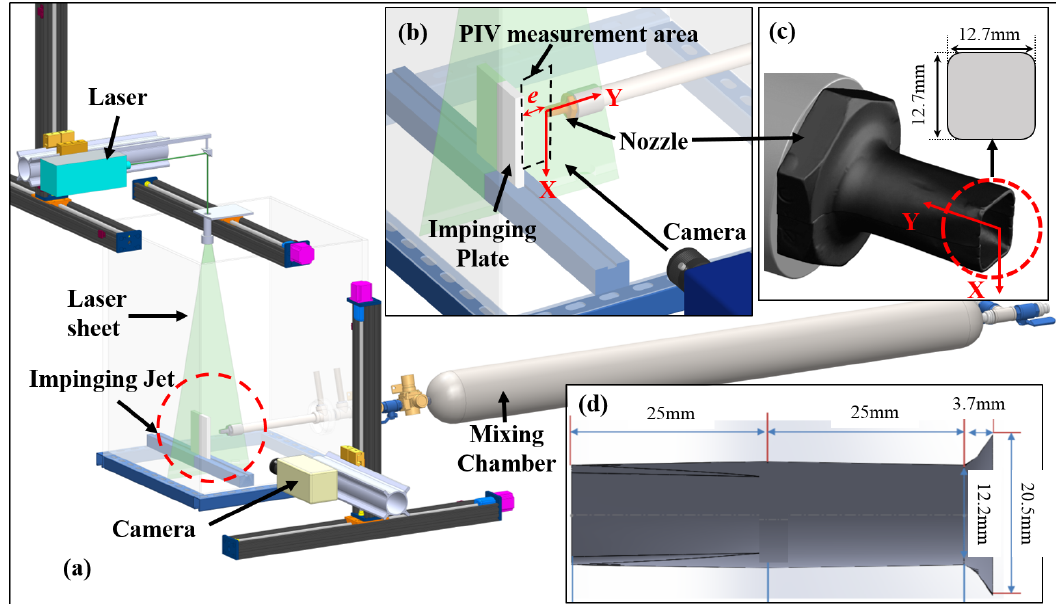
Figure 1. Overview of the experimental facility of the free jet and impinging jet. ( a , b ) Experimental rig and PIV experimental setup, ( c , d ) a close-view and dimensions of the tested